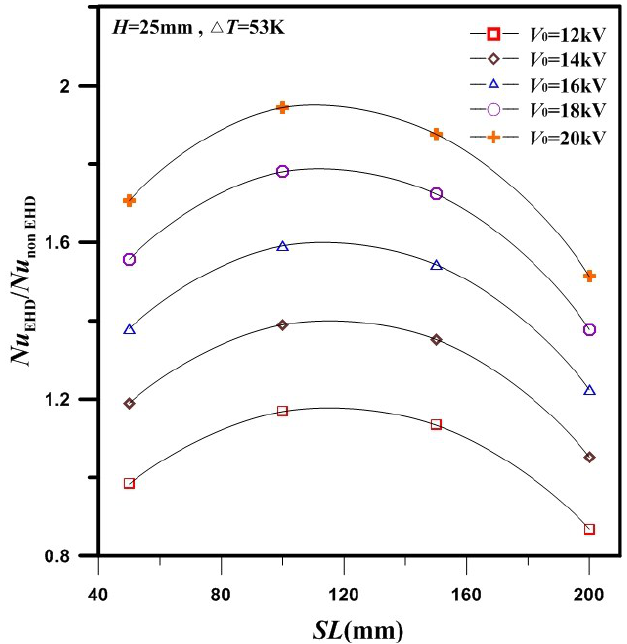
Figure 11. Variations in Nu EHD / Nu nonEHD versus electrode pitches SL for different applied voltages V 0 ( H = 25 mm and Δ T = 53 K).